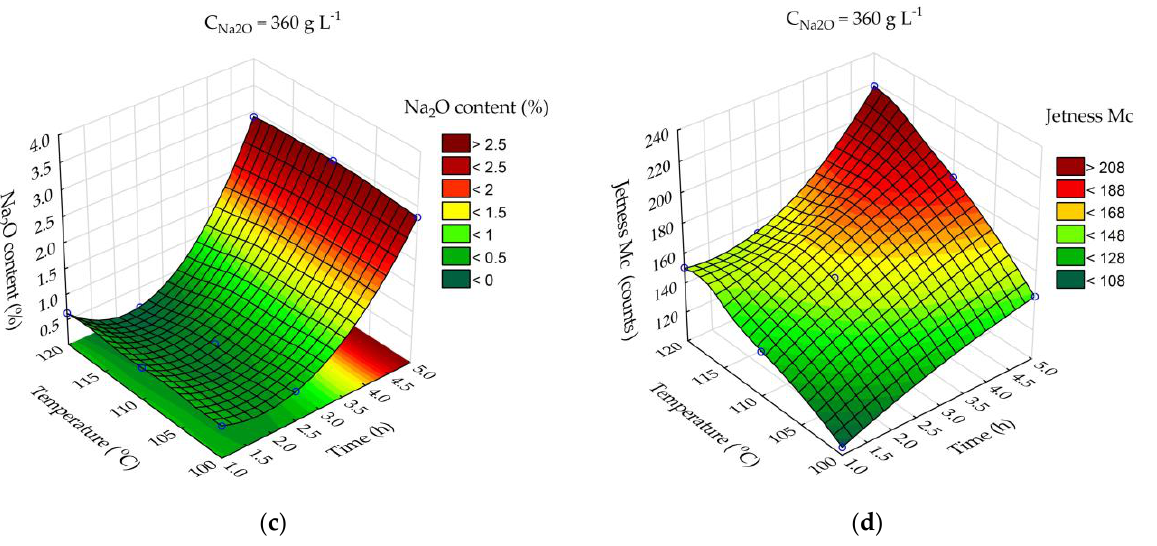
Figure 7. Neural network response surfaces for effect of time and temperature on Al extraction from sands ( a ); effect of time and temperature on Fe content in the sand residue ( b ); effect of time and temperature on Na 2 O content in the sand residue ( c ); effect of time and temperature on the jetness ( d ). As shown in Figure 6a, the major effect on Al extraction is caused by leaching